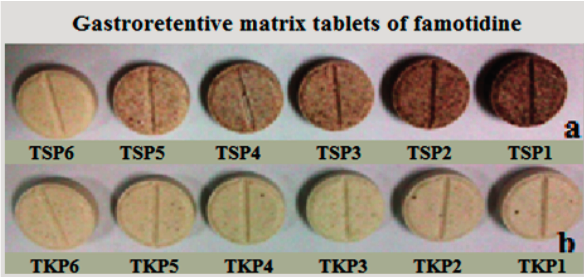
Figure 5. Floating gastroretentive matrix tablets of famotidine, prepared using TSP ( a ) and TKP ( b ) powders.